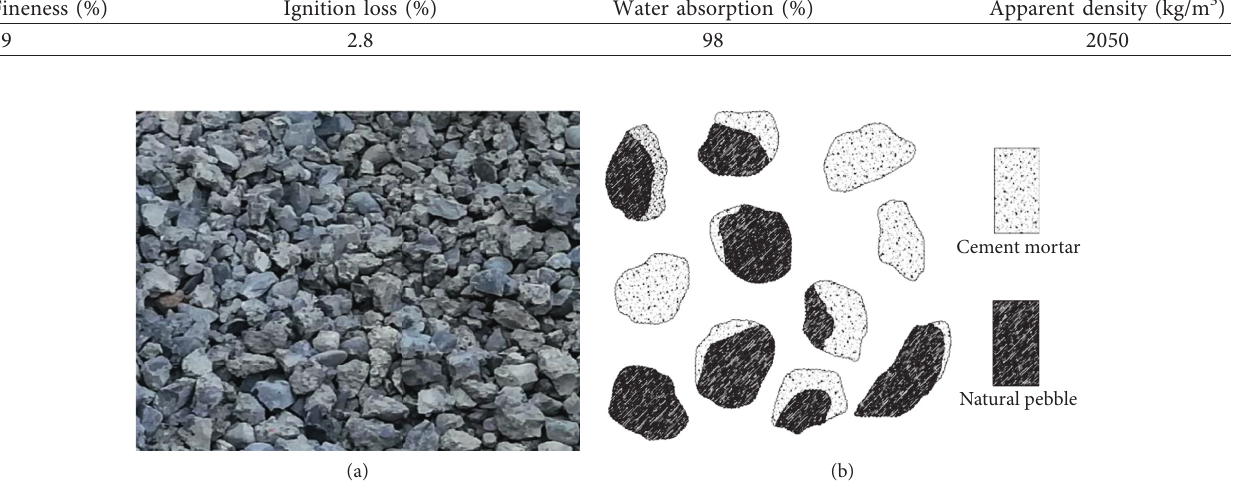
Table 2: Physical properties of fly ash.